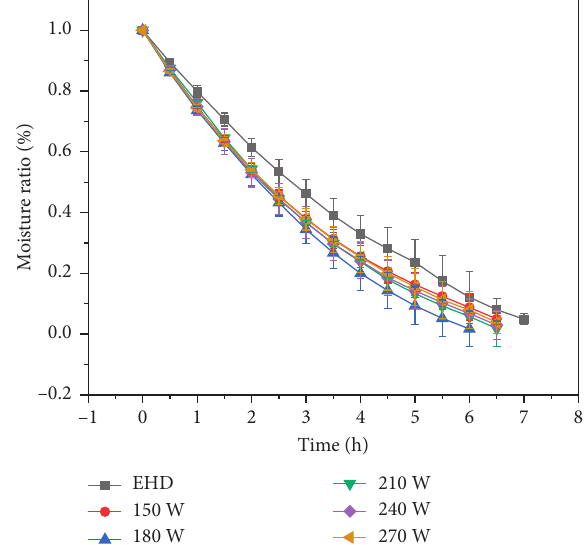
Figure 3: Diagram of the moisture ratio change in potato slices under different ultrasonic pretreatment